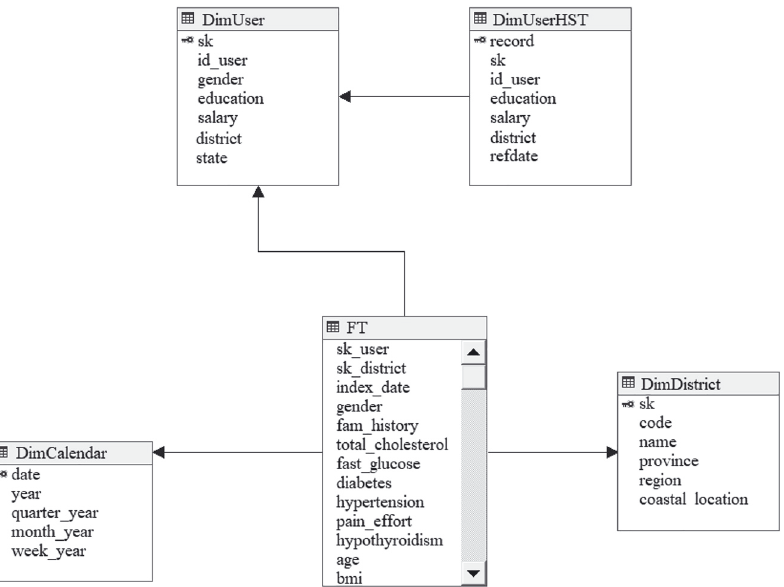
Figure 2: Implemented struc- tures in the data